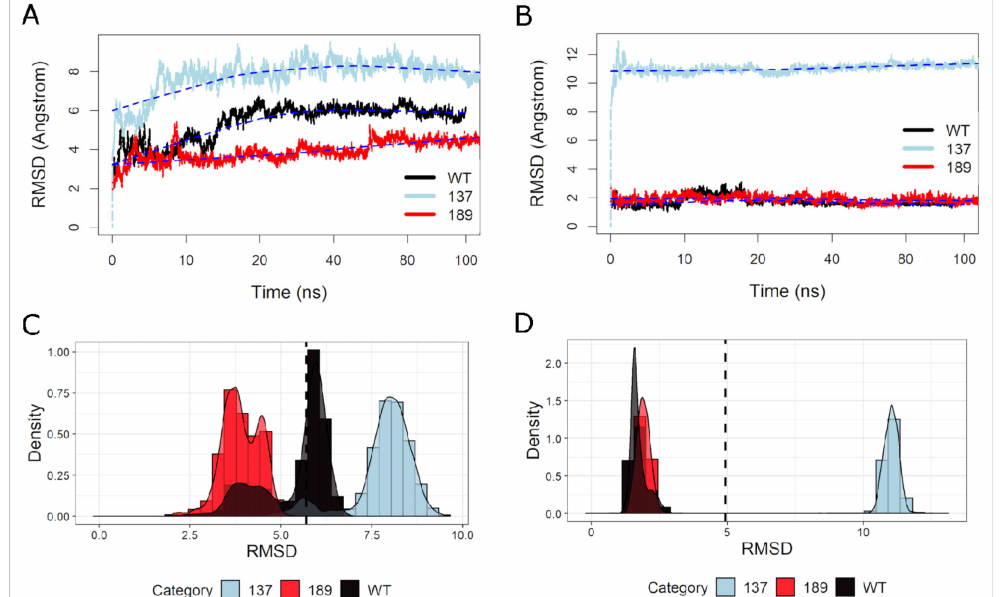
Figure 3. Root mean square deviation (RMSD) vs. MD simulation time and RMSD density of the three simulated NS3 structures. ( A ) The RMSD of three simulated NS3 “all” amino acid residues throughout the MD simulation compared to the starting structure (unphosphorylated WT at time 0 ns). The WT is shown in “black,” S137 is in “light blue,” and T189 is in “red.” ( B ) The RMSD density plots of each of three simulated NS3 “all” amino acid residues throughout the MD simulation compared to the starting structure (unphosphorylated WT at time 0 ns). The mean of all RMSD values = 5.6 is shown by the black vertical line. ( C ) The RMSD of three simulated NS3 amino acid residues (49–94) throughout the MD simulation compared to the starting structure (unphosphorylated WT at time 0 ns). ( D ) The RMSD density plots of each of three simulated NS3 amino acid residues (49–94) throughout the MD simulation compared to the starting structure (unphosphorylated WT at time 0 ns). The mean of all RMSD values = 5 is shown by the black vertical